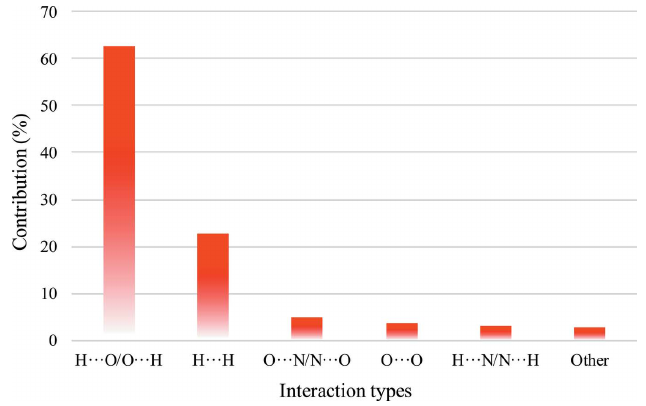
Figure 8 Quantitative results of different intermolecular contacts contributing to the Hirshfeld surface of 1